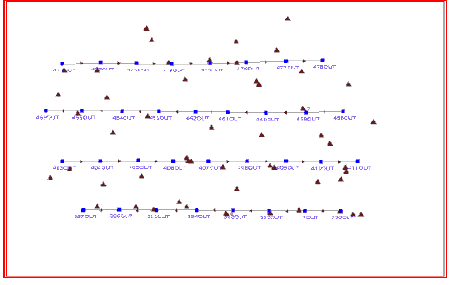
Figure 4. Photo-control points distribution of area